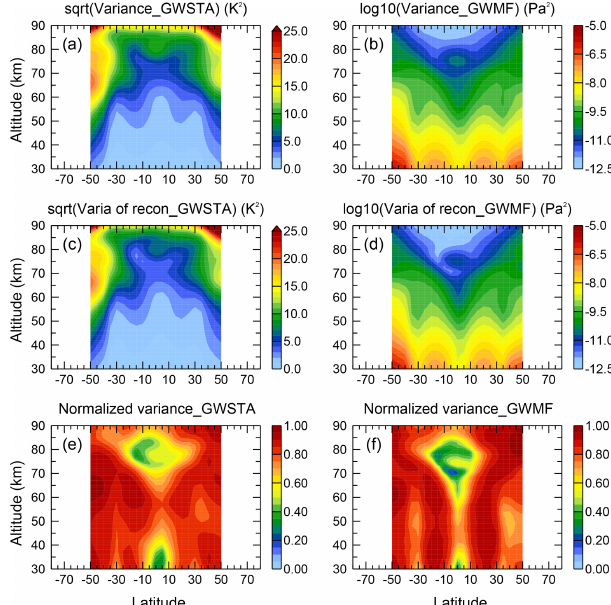
Figure 9. Altitude–latitude cross sections of the total variance con- tained in time series of SABER monthly-mean data for GW square temperature amplitudes (a) and absolute GW momentum flux (b) , the variance of the time series reconstructed from the four main pe- riods (c, d) , and the fraction of variance explained by the four main periods (e, f)